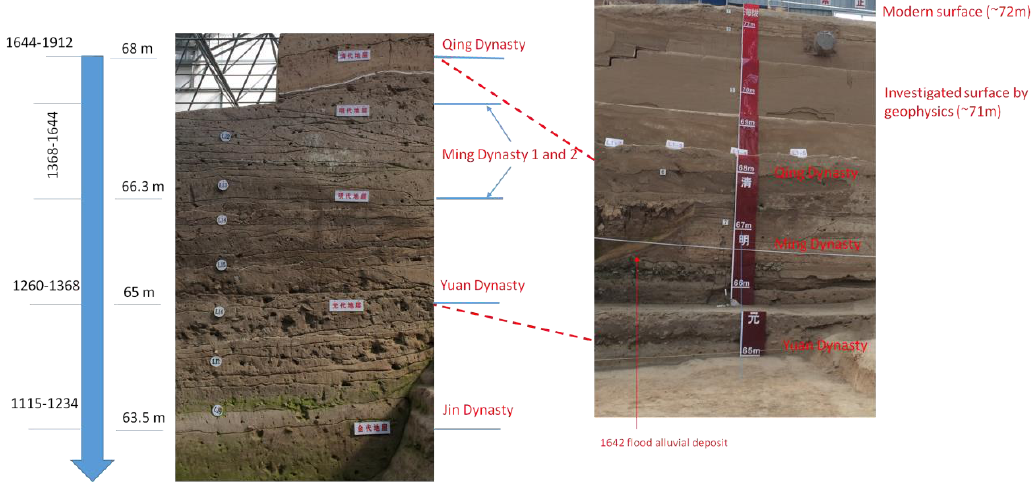
Figure 2. Archaeological stratigraphy in sector B (see Figure 1d,e) adjacent to the investigated area C which puts in evidence the depths of the diverse historical phases from Qing (1644–1912) to Jin Dynasty (1115–1234). Please, note that the stratigraphy clearly evidences alluvial deposits